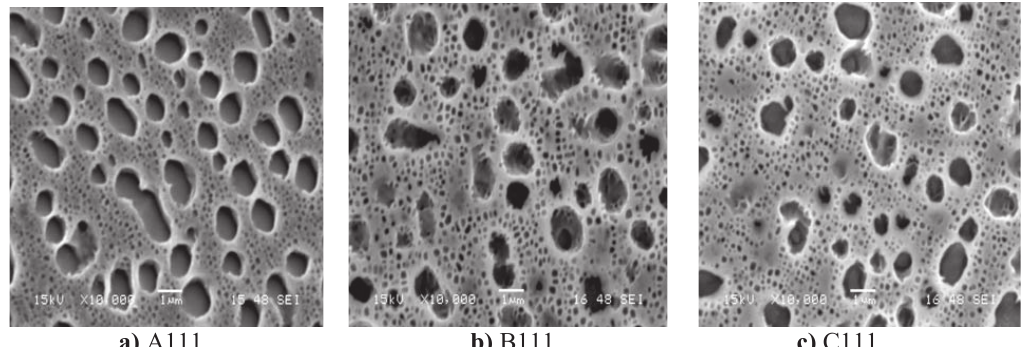
Figure 21. Microstructures of specimens after reheat treatment of Program 4.